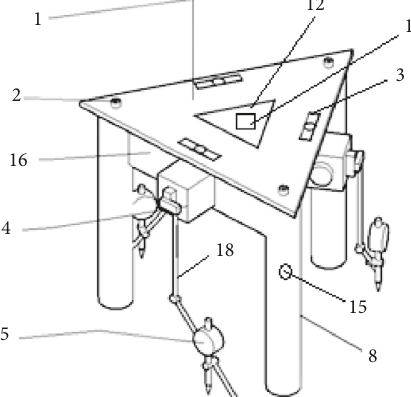
Figure 15: Structural representation.